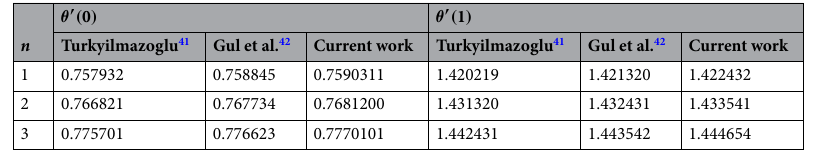
Table 6. Comparison of Nusselt number results for disk and cone with those of previous research 41,42 utilizing just the common